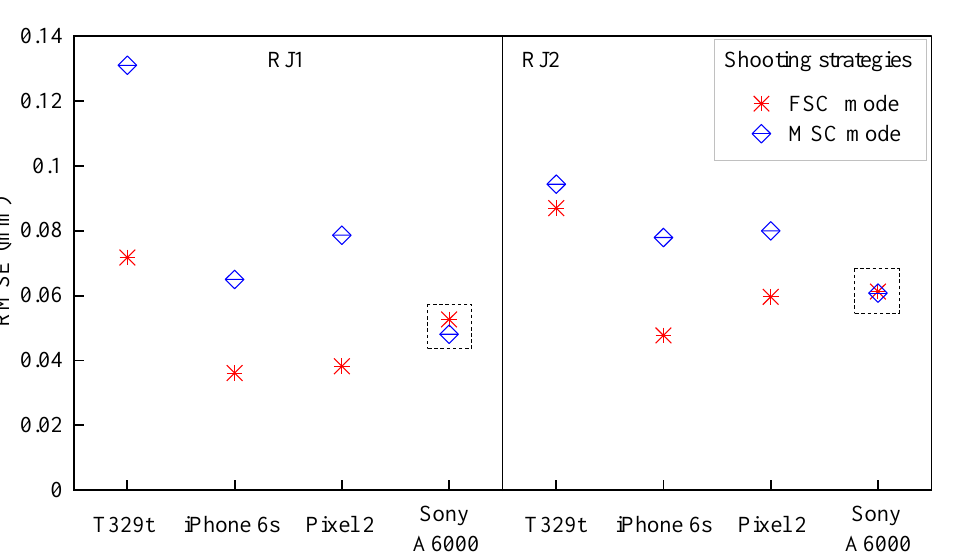
Figure 10. The RMSE of the SfM models under the MSC mode and FSC mode with a shooting angle of 60°.